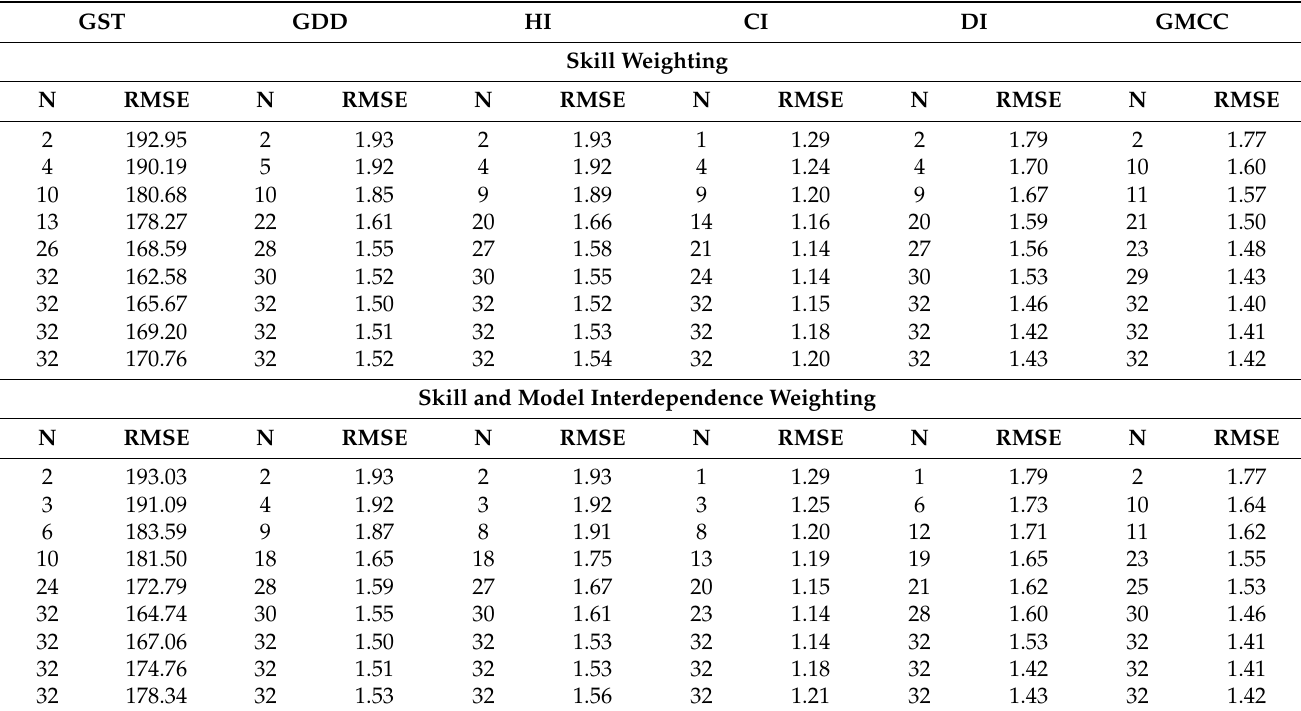
Table 4. For the Willamette Valley American Viticultural Area (AVA) and growing season average temperature (GST), growing degree days (GDD), Huglin index (HI), cool night index (CI), dryness index (DI), and the G é oviticulture multicriteria